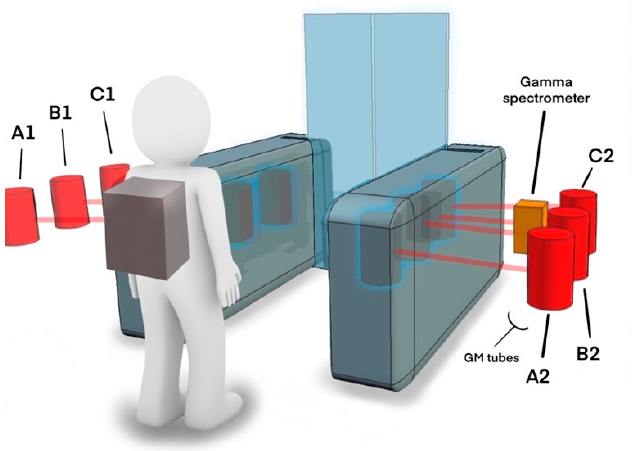
Figure 2. Schematic of the Project Gatekeeper portal system, illustrating the locations of the six distributed Geiger–Muller (GM) detectors (“A1, A2, B1, B2, C1, C2”) and the solid-state miniaturised gamma spectrometer.